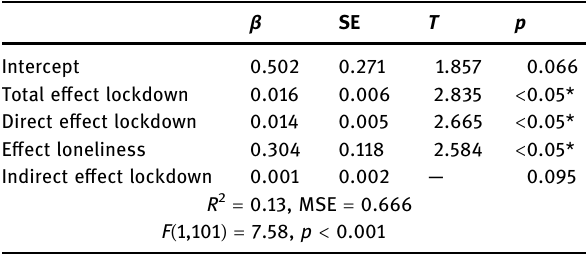
Note. Calculated with PROCESS Macro, Model 4 [ 74 ] .